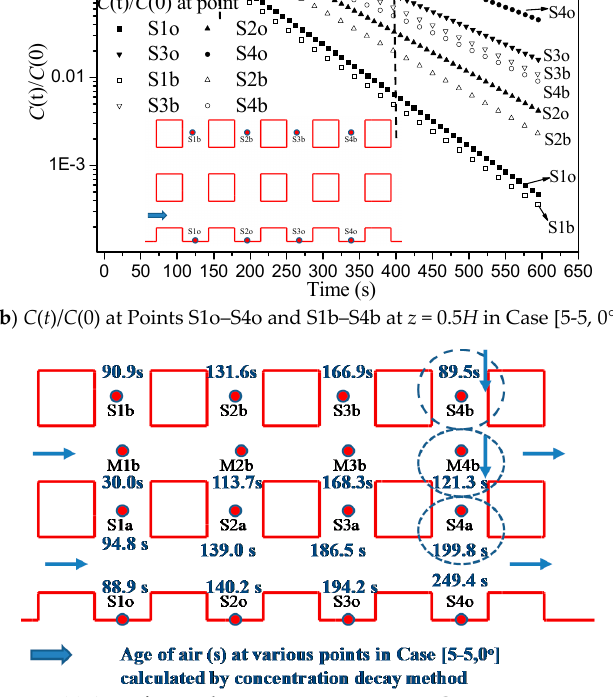
( c ) Age of air at these points at z = 0.5 H in Case [5-5, 0°] Figure 5. C ( t )/ C (0) in Case [5-5, 0 ° ]: ( a ) at Points S1a–S4a and M1b–M4b in z = 0.5 H , ( b ) at Points S1o– S4o and S1b–S4b in z = 0.5 H .